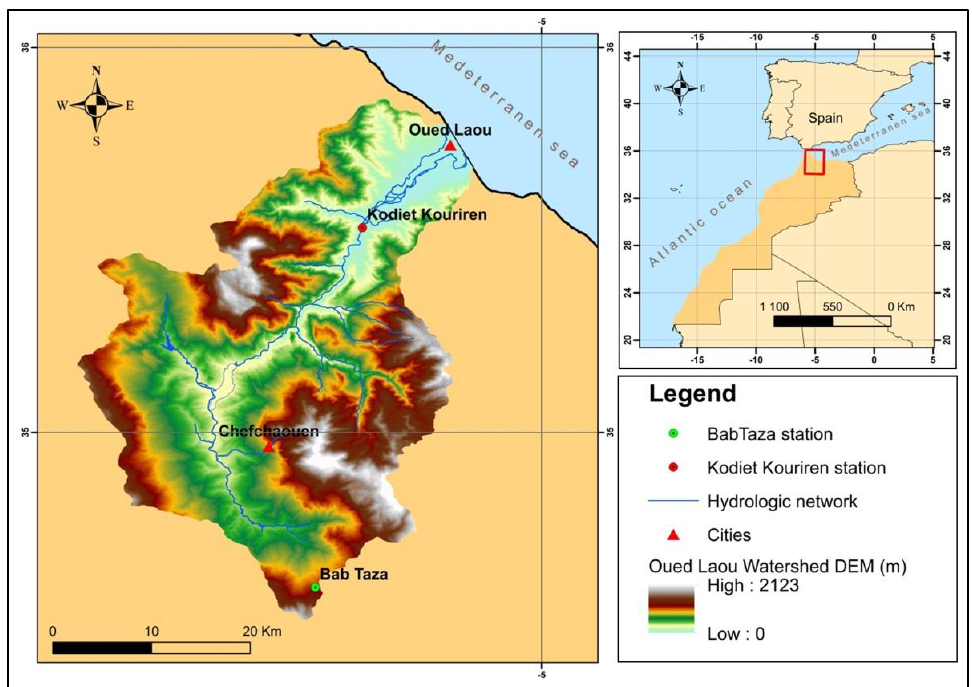
Figure 1. Location map showing the spatial distribution of the OLW in northern Morocco and the location of rain gauge stations.